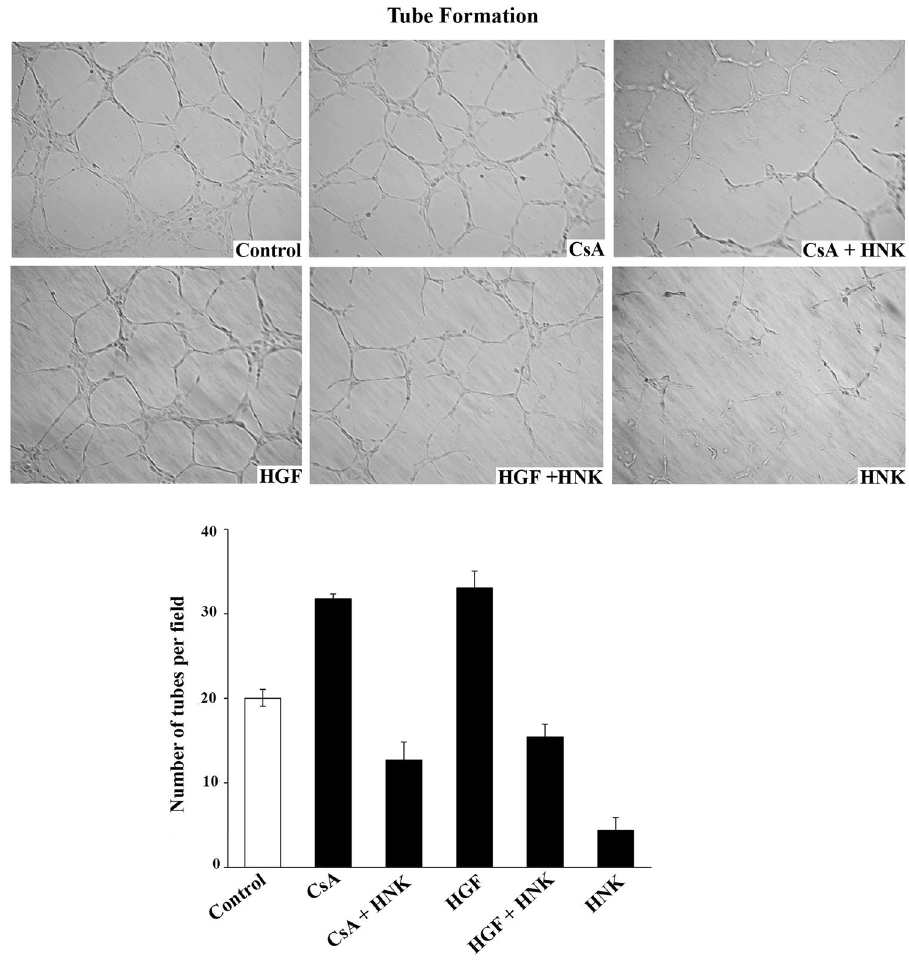
Figure 4. HNK down-regulates both c-Met- and CNI-induced secretion of angiogenic factors from renal cancer cells: The magnitude of secretion of angiogenic factors from renal cancer cells was assessed by in vitro tube formation assay using HUVEC cells (as described in “Materials and Methods” section). 786-O cells were pre-treated with either HNK (20 μ M) or vehicle alone for 2 h and then treated with different combinations of HGF (50 ng/ml), CsA (5 μ M) or vehicle alone for 12 h. Following treatment, cell culture medium was replaced with serum free culture medium and cells were grown for an additional 24 h. Subsequently, culture supernatants from each of the indicated treatments were collected and utilized to culture HUVEC cells on growth factor- reduced extracellular matrix (Geltrex). Representative images of capillary-like tube formation of HUVEC cells, taken with phase contrast microscope, are shown. The extent of tube formation was quantified by counting the number of uninhibited polygonal tube-like structures in five randomly selected microscopic fields ( bottom bar diagram). Images are representative of three independent experiments; and in bar diagram columns represent the ± S.D. of three independent